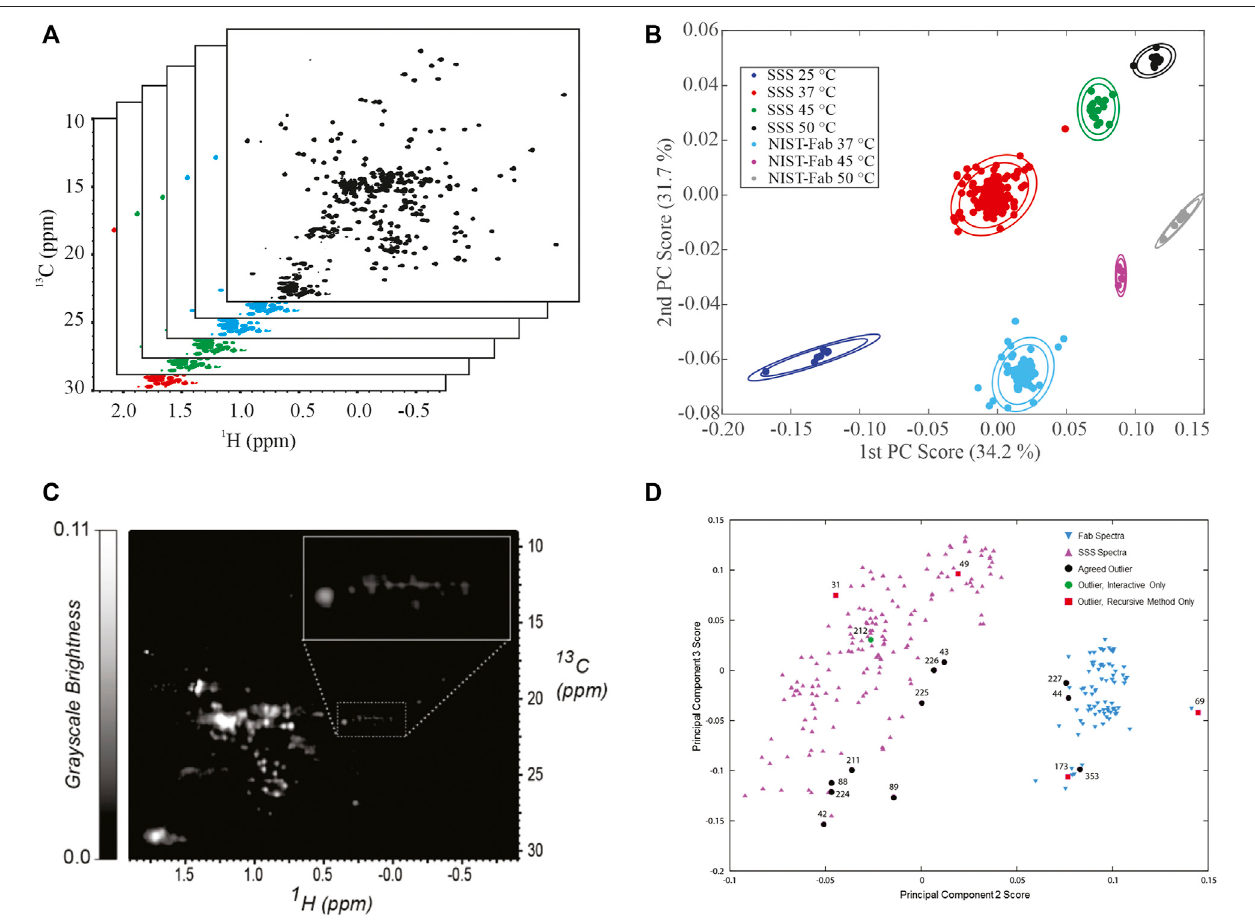
FIGURE 4 | Representative Analysis of Data from NMR interlaboratory study. (A) simulated data package of many 1H, 13C methyl fi ngerprints; (B) PCA score plot of the interlaboratory NMR study; (C) Converted grayscale image of a 1H, 13C methyl fi ngerprint; (D) PCA score plot of 252 spectra used in the automated analysis of outliers. Panel 5B was reprinted from Brinson et al. , 2019 (https://doi.org/10.1080/19420862.2018.1544454), with permission from Taylor and Francis Group, LLC. Please note the article was published under a creative commons open access license. Permission is granted subject to the terms of the License under which the work was published. Panels 5C and 5D were Reprinted from Sheen et al., 2020 (https://doi.org/10.1016/j.chemolab.2020.103973) with permission from Elsevier.